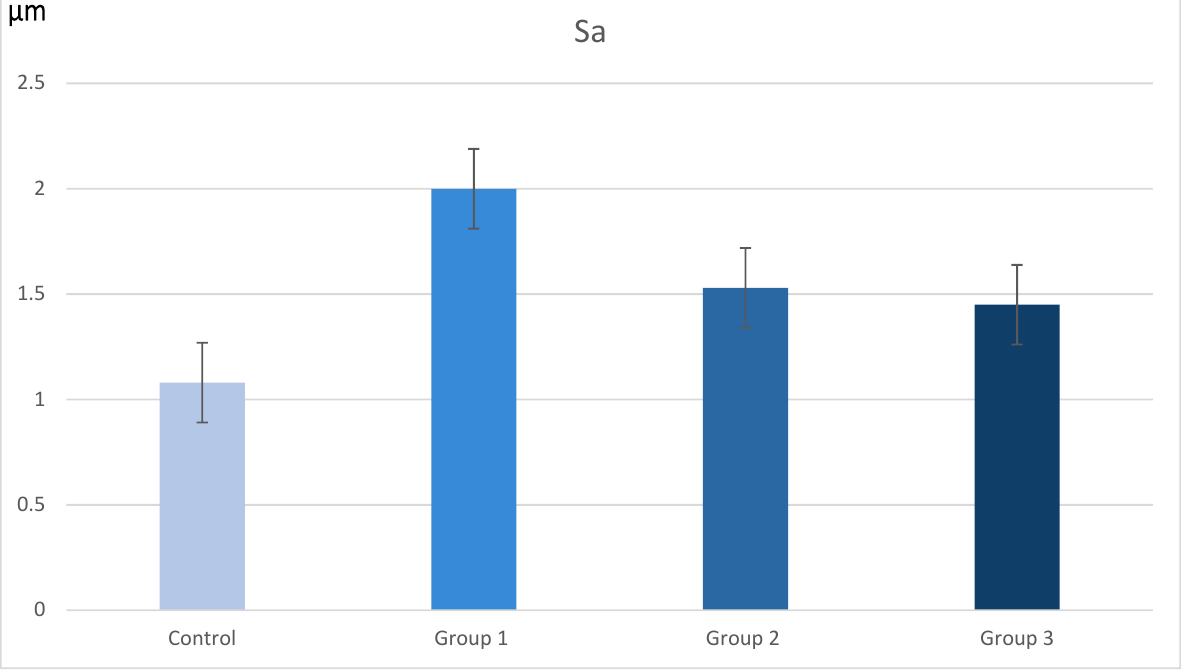
Table 4. Mean and median values of the three variables in µ